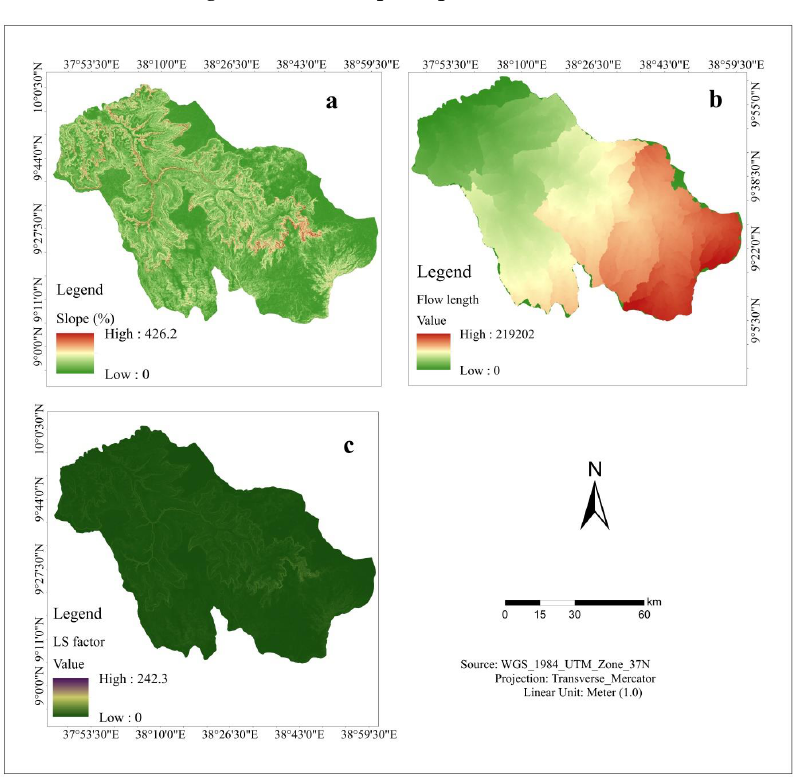
Figure 6. Map of slope in percent ( a ); flow length ( b ) and Slope Length-steepness (LS) factor ( c ) of the Muger sub- basin.